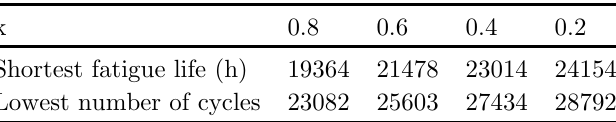
Table 15. Von Mises stress at characteristic nodes of turbine disc for different k values.